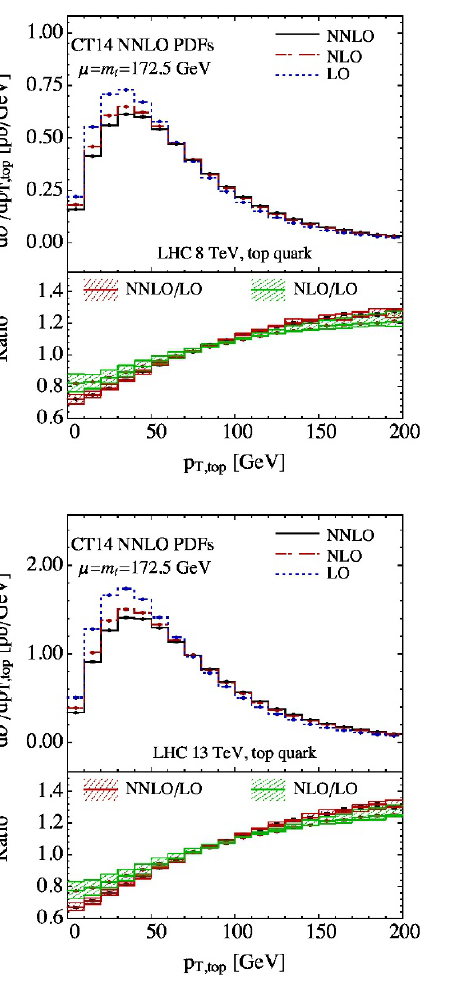
Figure 19 . Predicted transverse momentum distribution of the top (anti-)quark from t -channel single top-quark production at 8 and 13